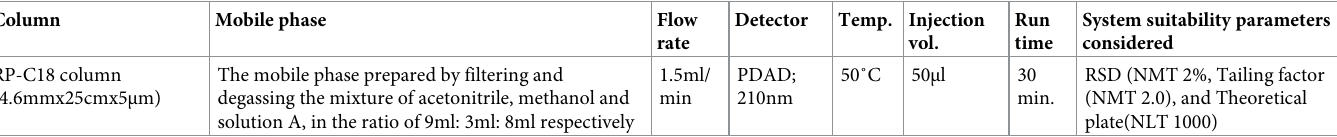
Table 2. Chromatographic condition for analysis of the content of active ingredients of azithromycin. Column Mobile phase Flow